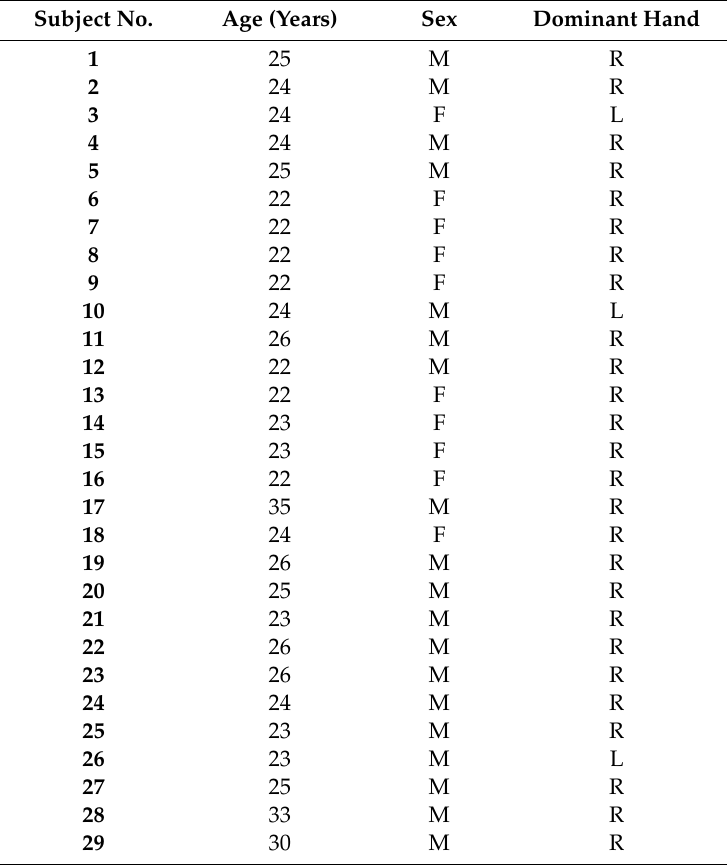
Table 1. Characteristics of 29